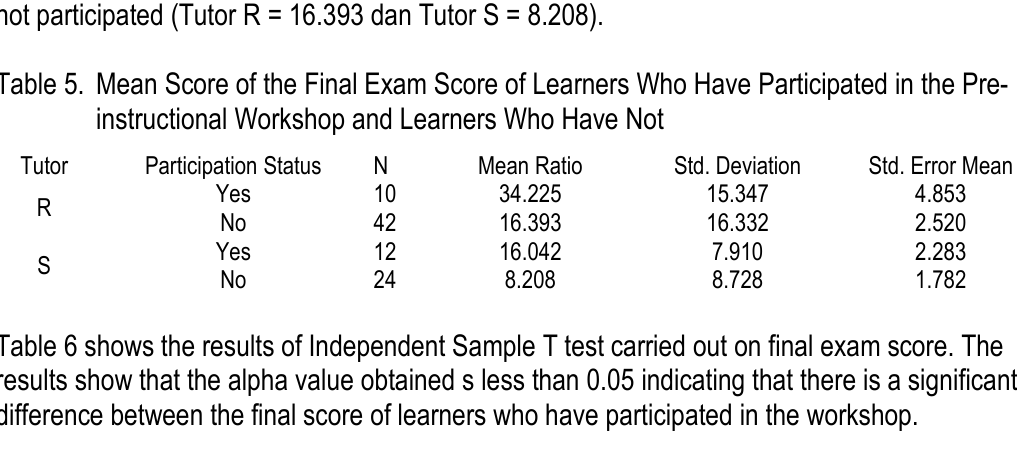
Table 6. Independent Sample T Test Carried Out on Online Participation Ratio for Both Participants and Non-participants Attached to Tutor R and S Respectively